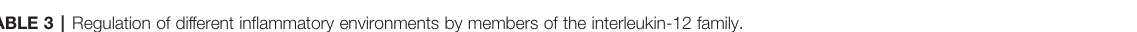
TABLE 3 | Regulation of different in fl ammatory environments by members of the interleukin-12 family.